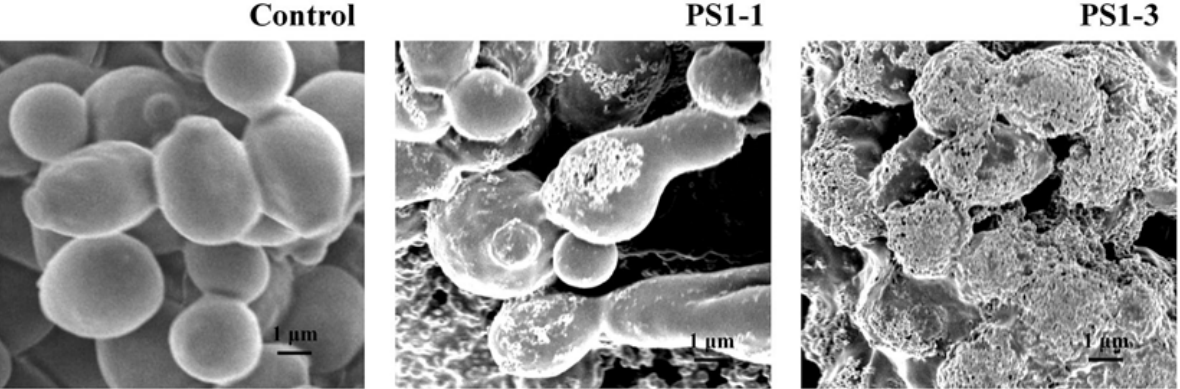
Figure 3. Morphological characterization of cell surface of the peptide-treated C. albicans ATCC 14007. After incubation of C. albicans CCARM 14007 cells with/without PS1-1 or PS1-3 peptide at the MFC for 1 h, membrane damage values of the cells were examined by using a scanning electron microscope (SEM). Scale bar = 1 μ m.